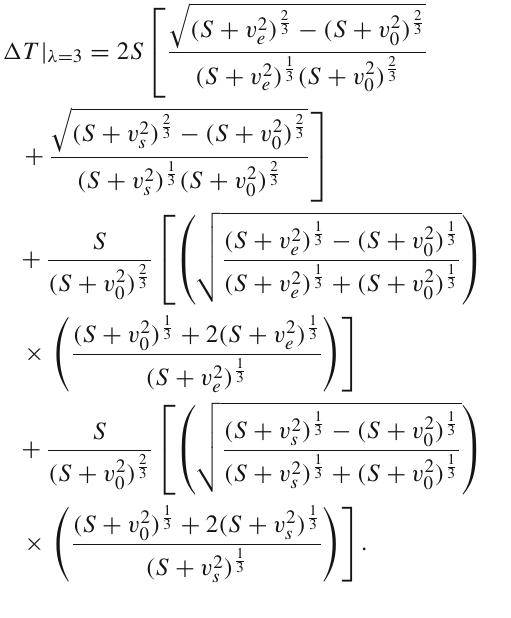
deflection angle actually